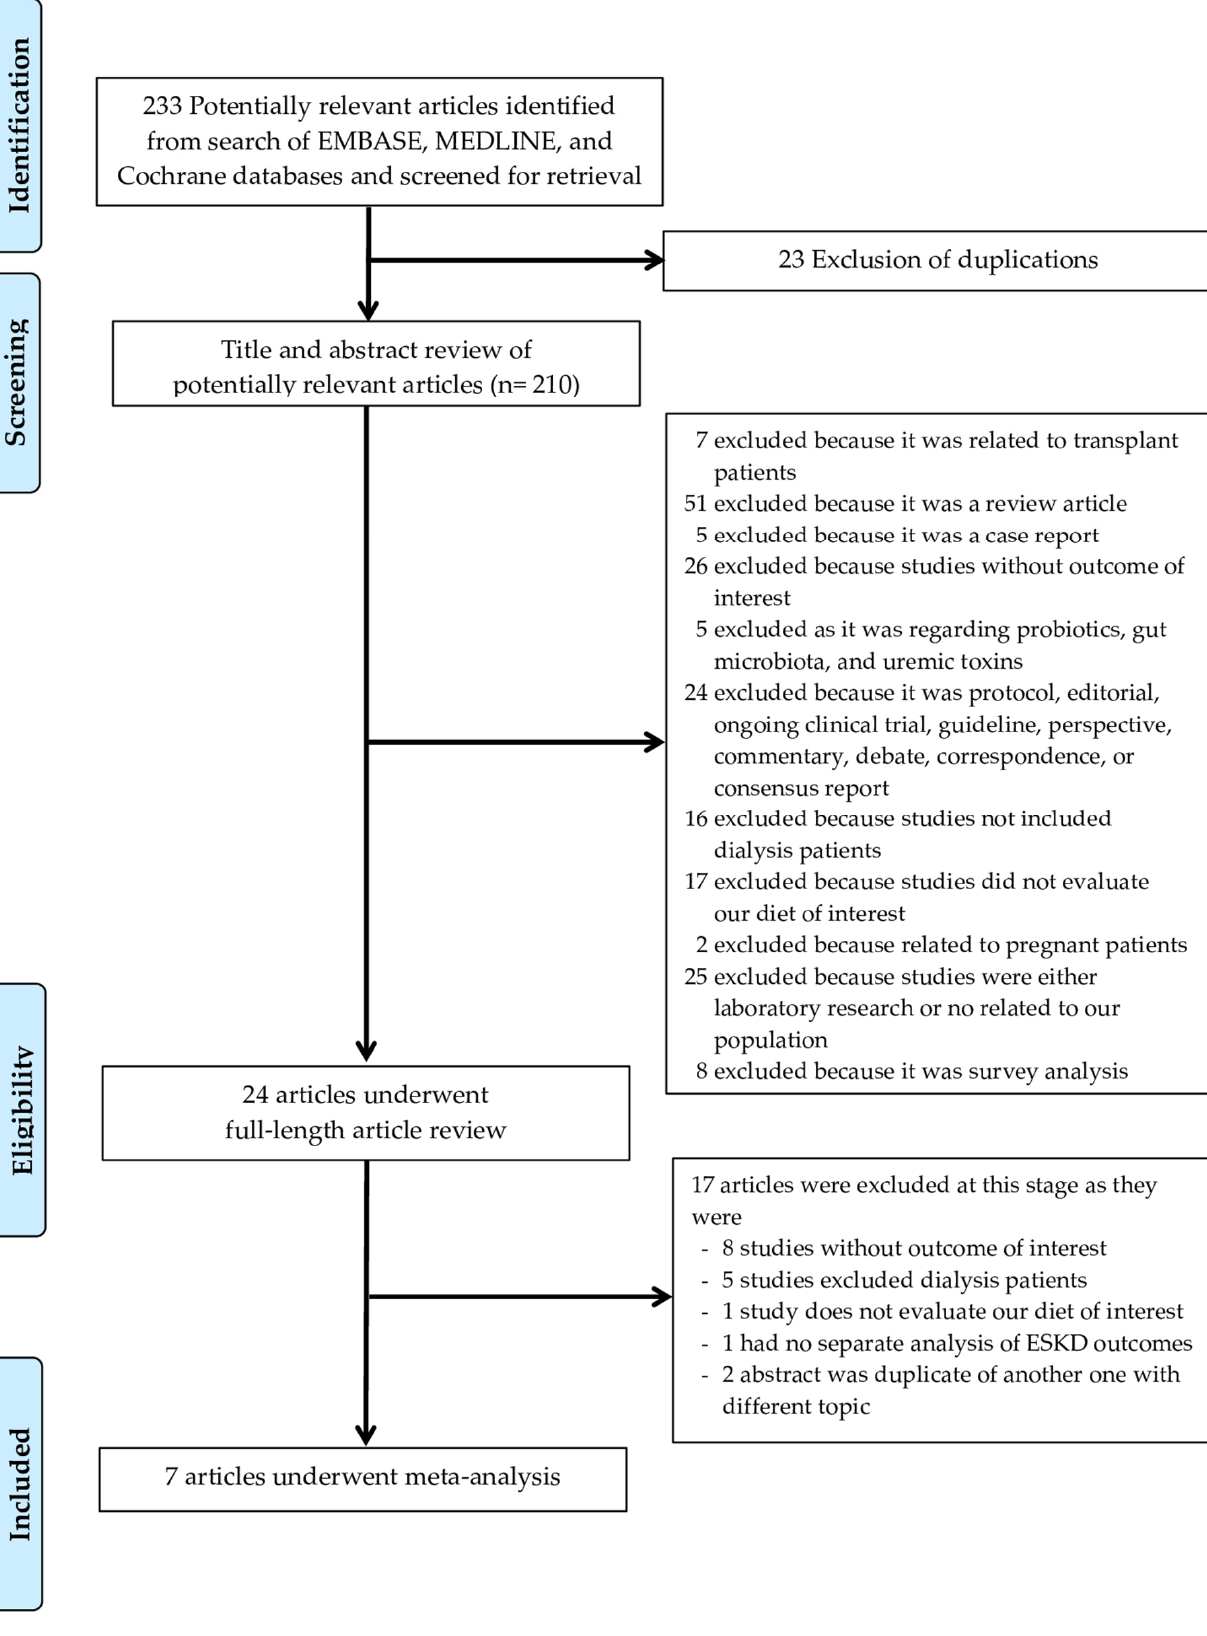
Figure 1. Literature Review Process.